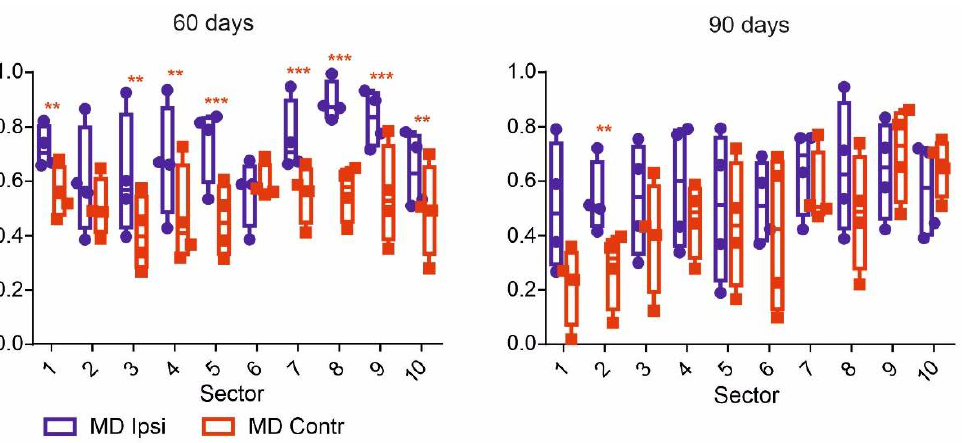
Figure 4. Diff MD values (see Equation (2)) in MD kitten groups aged 60 and 90 days. ** p < 0.01, *** p < 0.001 —significance level with respect to contralateral hemisphere. *** p < 0.001—significance level with respect to contralateral